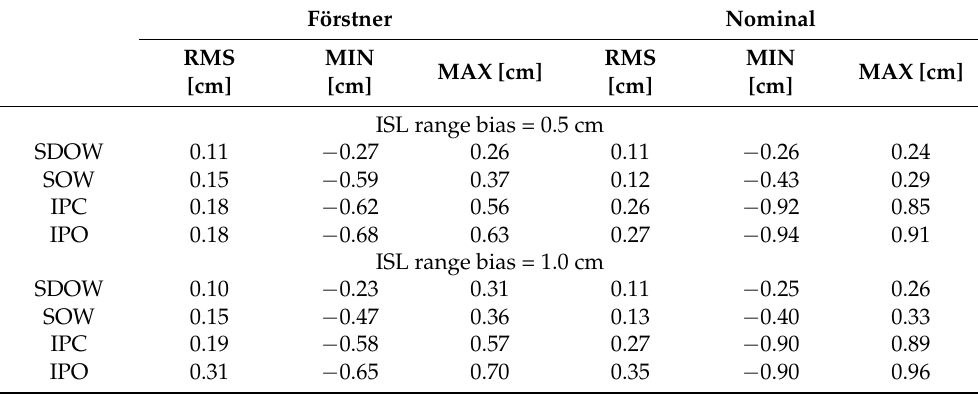
Table 6. Statistics of differences between simulated and estimated values of biases with reference to weighting and connectivity schemes. Presented values are computed for all simulation scenarios with estimated ISL range bias (regardless the ground station set).